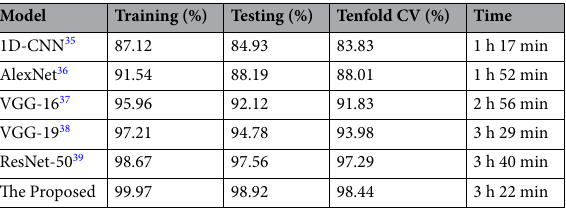
The Proposed Table 4. Comparison of the overall accuracy between the proposed method model and other neural network models in this table.